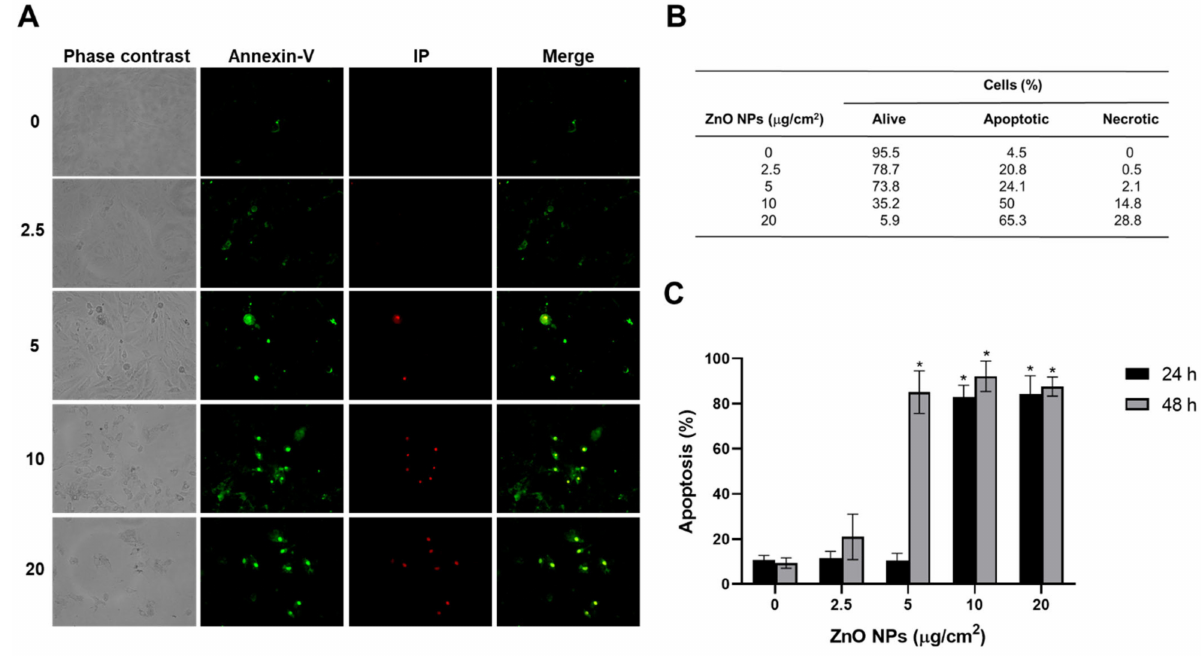
Figure 9. ZnO NPs effect on cell death. Apoptotic and necrotic cells were detected using annexin-V and propidium iodide, respectively. Cells (1 × 10 6 ) were exposed to 0, 2.5, 5, 10, and 20 µ g/cm 2 of ZnO NPs. In ( A ), cell micrographs of a representative experiment after 48 h of exposure to ZnO NPs were taken by a fluorescence microscope with a 20X objective. In ( B ), the percentage of apoptotic and necrotic cells after 48 h of exposure is shown. In ( C ), flow cytometric analysis of cells is presented as mean ± standard deviation of three independent experiments. * p < 0.05 compared with